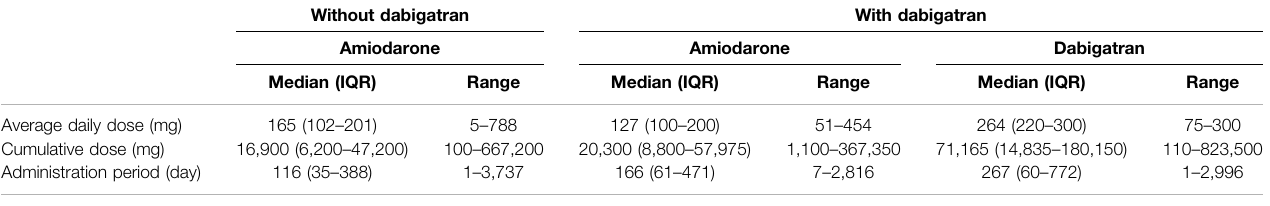
TABLE 3 | Diagnosis of interstitial lung disease (ILD) given to patients taking amiodarone in JMDC data. Number of ILD cases in 3 years